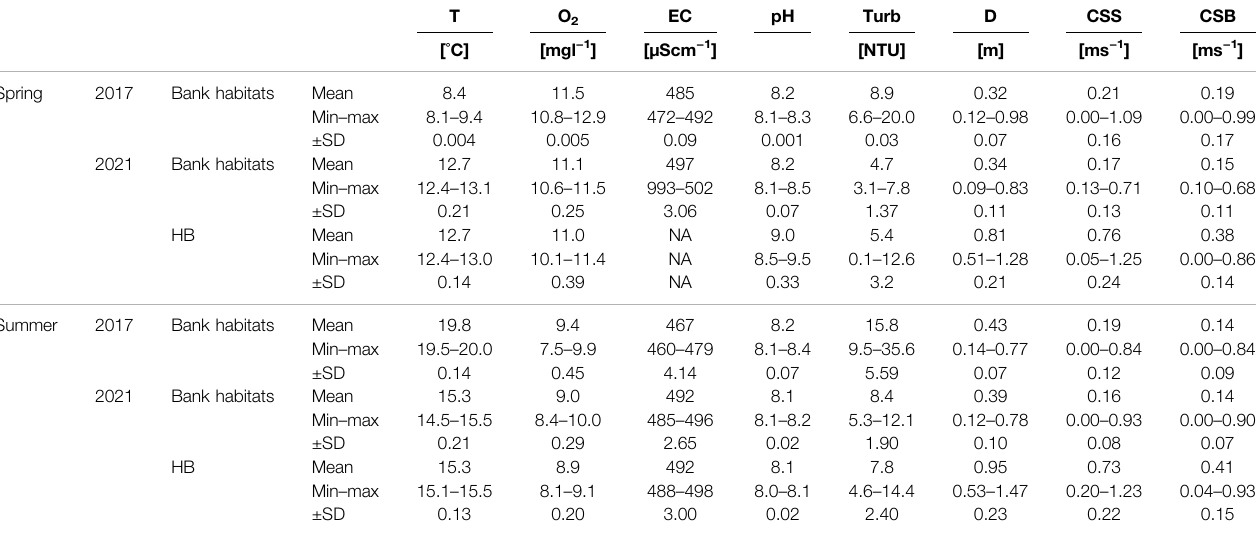
TABLE 2 | Important physicochemical variables measured in the sampling stretches of the Hammerbach (HB) and the restored bank habitats in spring and summer 2017 and 2021. T O 2